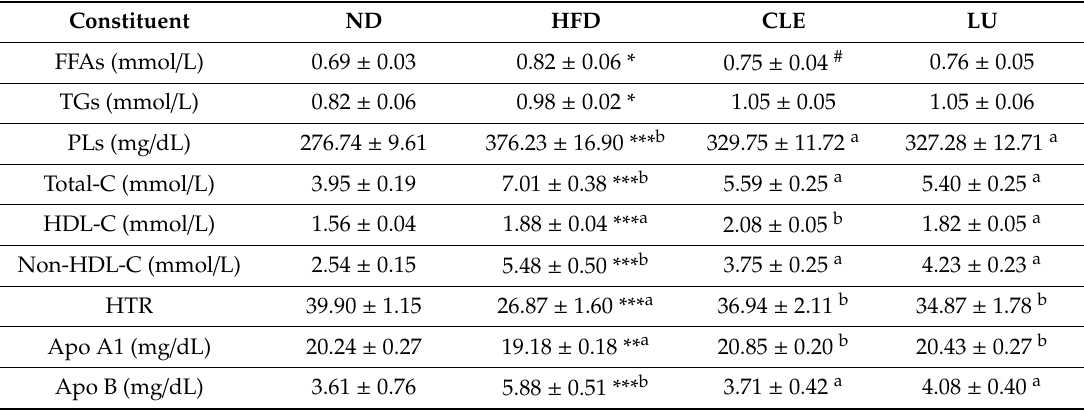
Table 1. E ff ects of chrysanthemum leaf ethanol extract and luteolin supplements for 16 weeks on plasma lipid levels in C57BL / 6J mice fed high-fat